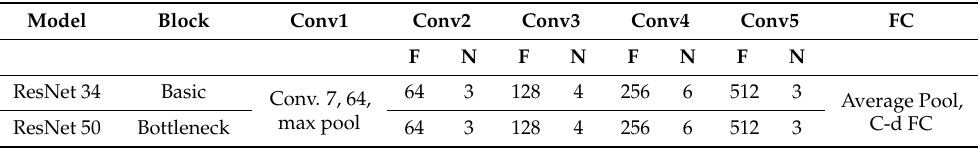
Table 1. 3D ResNet architecture for 34 and 50 depth. Both architectures consist of 5 successive convolution layers ranging from Conv1 to Conv5. Block denotes basic component in every layer except Conv1. FC is the last fully connected layer for classification. F indicates the channel of output features of every layer, and N indicates the number of basic